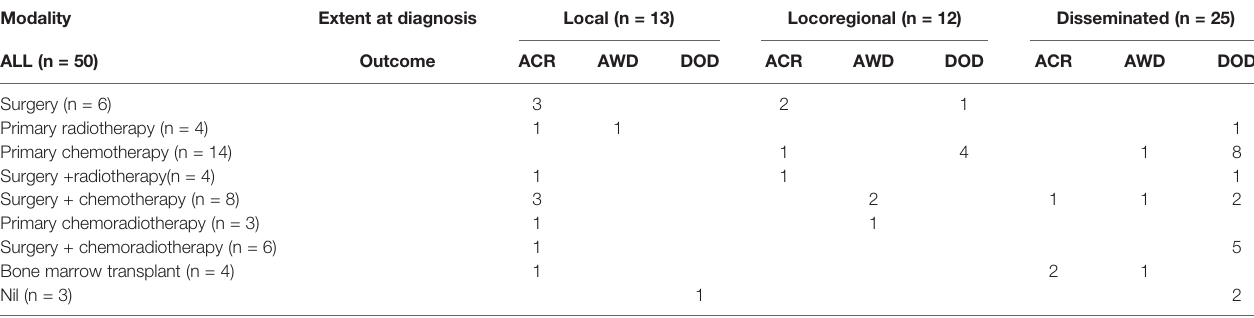
TABLE 3 | Outcomes by individual management